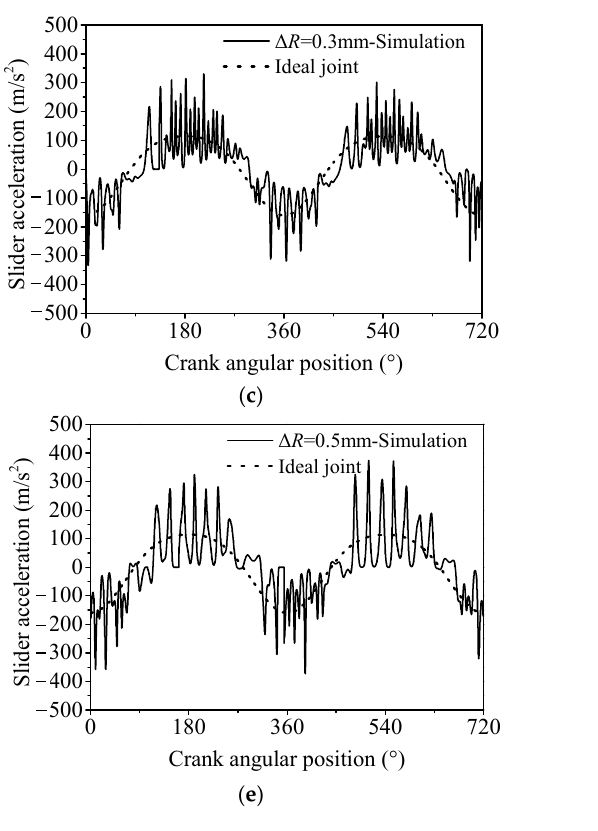
Figure 5. Comparison results of the slider acceleration with clearance sizes defining as 0.1, 0.3, 0.5 mm respectively: ( a , c , e ) simulations; ( b , d , f ) experiments [29]. Table 4. Relative errors of the oscillation peaks of the slider acceleration between simulation and experiment results.